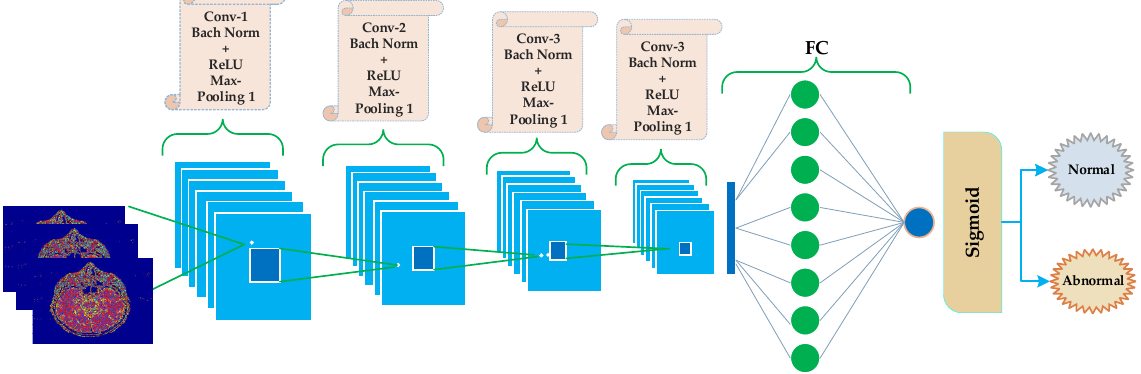
The proposed CNN structure consists of five blocks, as shown in Figure 4. The first four blocks are the same, holding convolution, batch normalization, ReLU, and max-pooling layers. The last (5th) block is different from the previous four blocks. The fifth layer contains the FC layer following by a sigmoid layer.